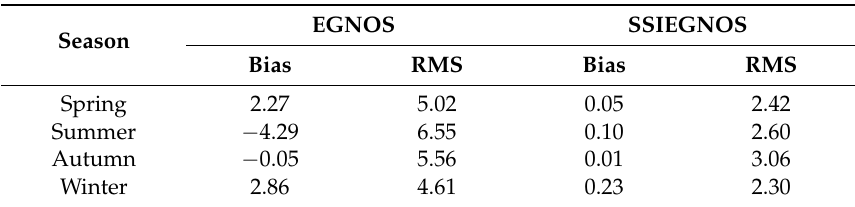
Figure 4. Variation of the monthly bias and RMS error in 2008–2010 over Asia. Yellow bars and red bars indicate the bias and RMS error of the EGNOS model and SSIEGNOS model, respectively. Table 1. Seasonal variation of the bias and RMS error of the EGNOS and SSIEGNOS models in 2008–2010 over Asia (Unit: cm).